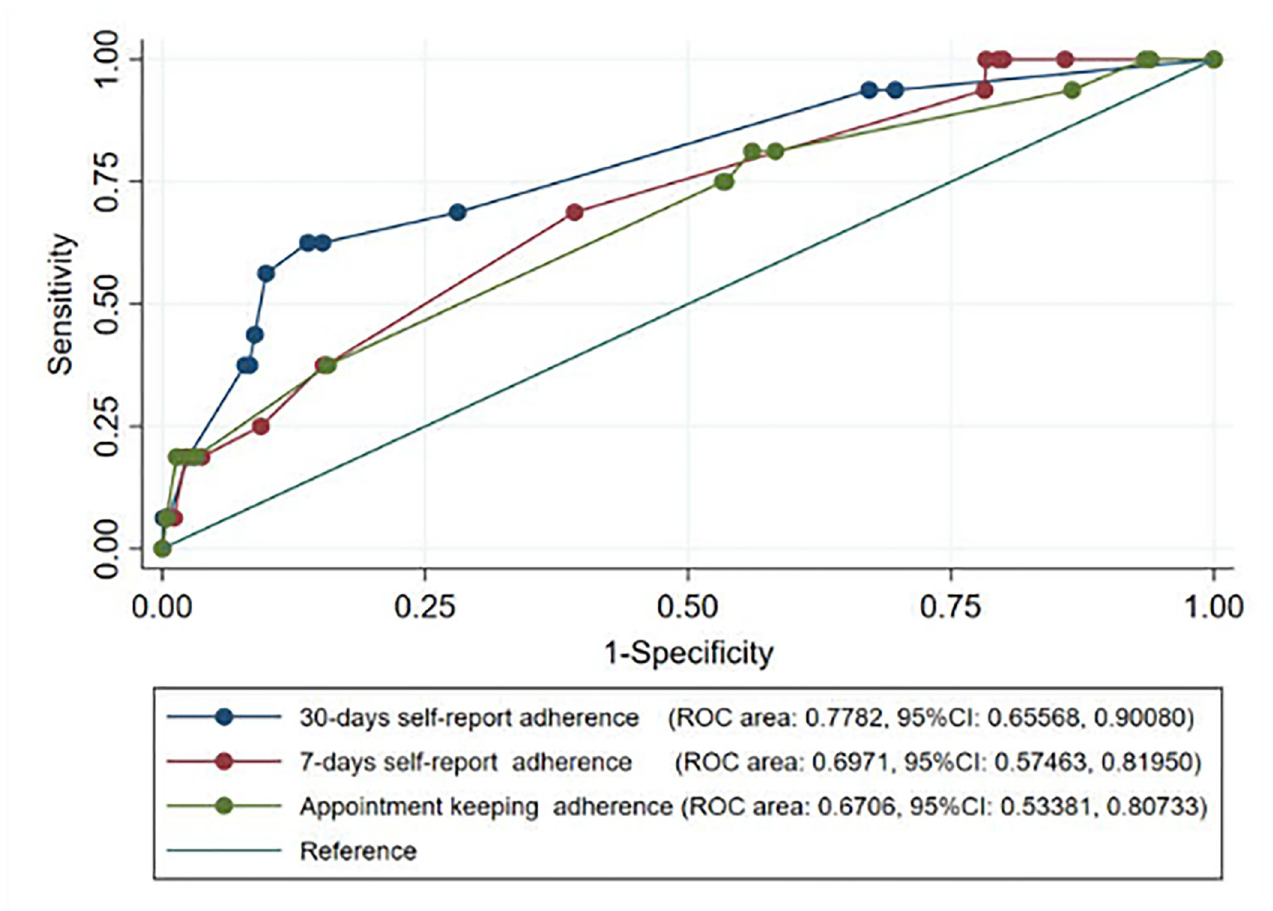
Fig 3. Roc curves for the three ART adherence measures in predicting virological failure. Predictivity ability of three adherence measure in predicating virological failure among long-term ART person.